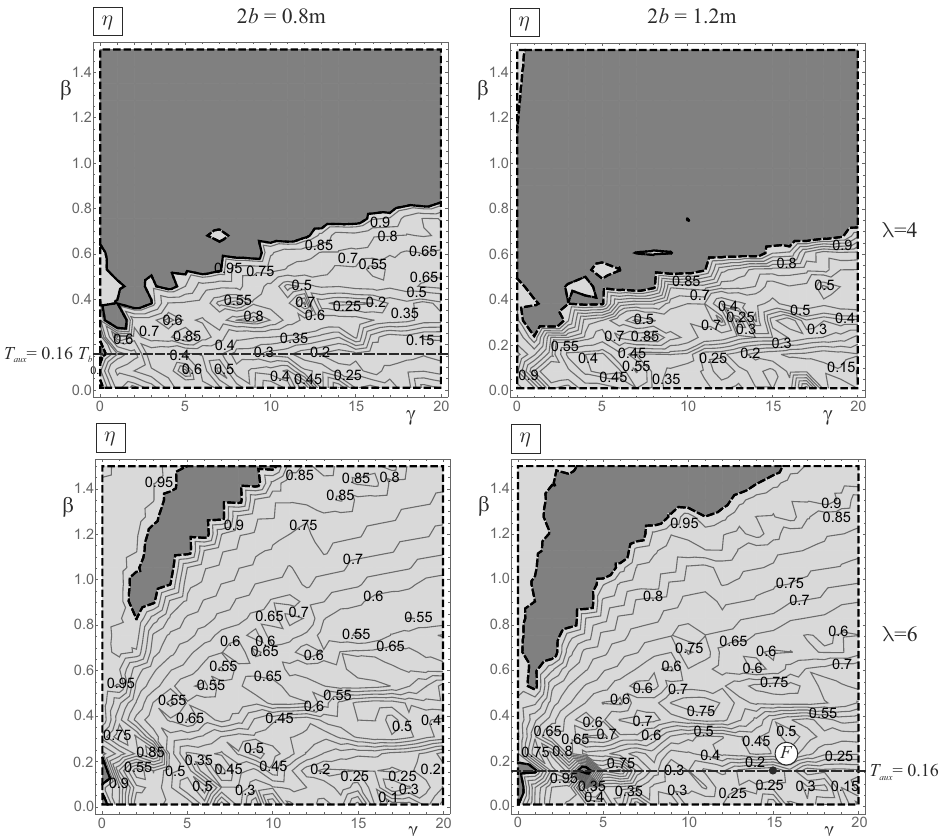
Figure 11. Gain maps obtained for different dimensions of the rigid blocks and under the L’Aquila seismic record ( m = 0.05 M , u y = 1/3 u cr , ψ = 0.2). The maps are arranged in matrix form where the rows refer to different values of λ ( λ = 4, λ = 6) and the columns refer to different values of 2 b (2 b = 0.8 m, 2 b = 1.2 m). The restitution coefficients of the rigid blocks related to gain maps in Figure 11 are: (1) r = 0.9118 for the rigid block with 2 b = 0.8 m and λ = 4; (2) r = 0.9595 for the rigid block with 2 b = 0.8 m and λ = 6; (3) r = 0.9118 for the rigid block with 2 b = 1.2 m and λ = 4; (4) r = 0.9595 for the rigid block with 2 b = 1.2 m and λ =